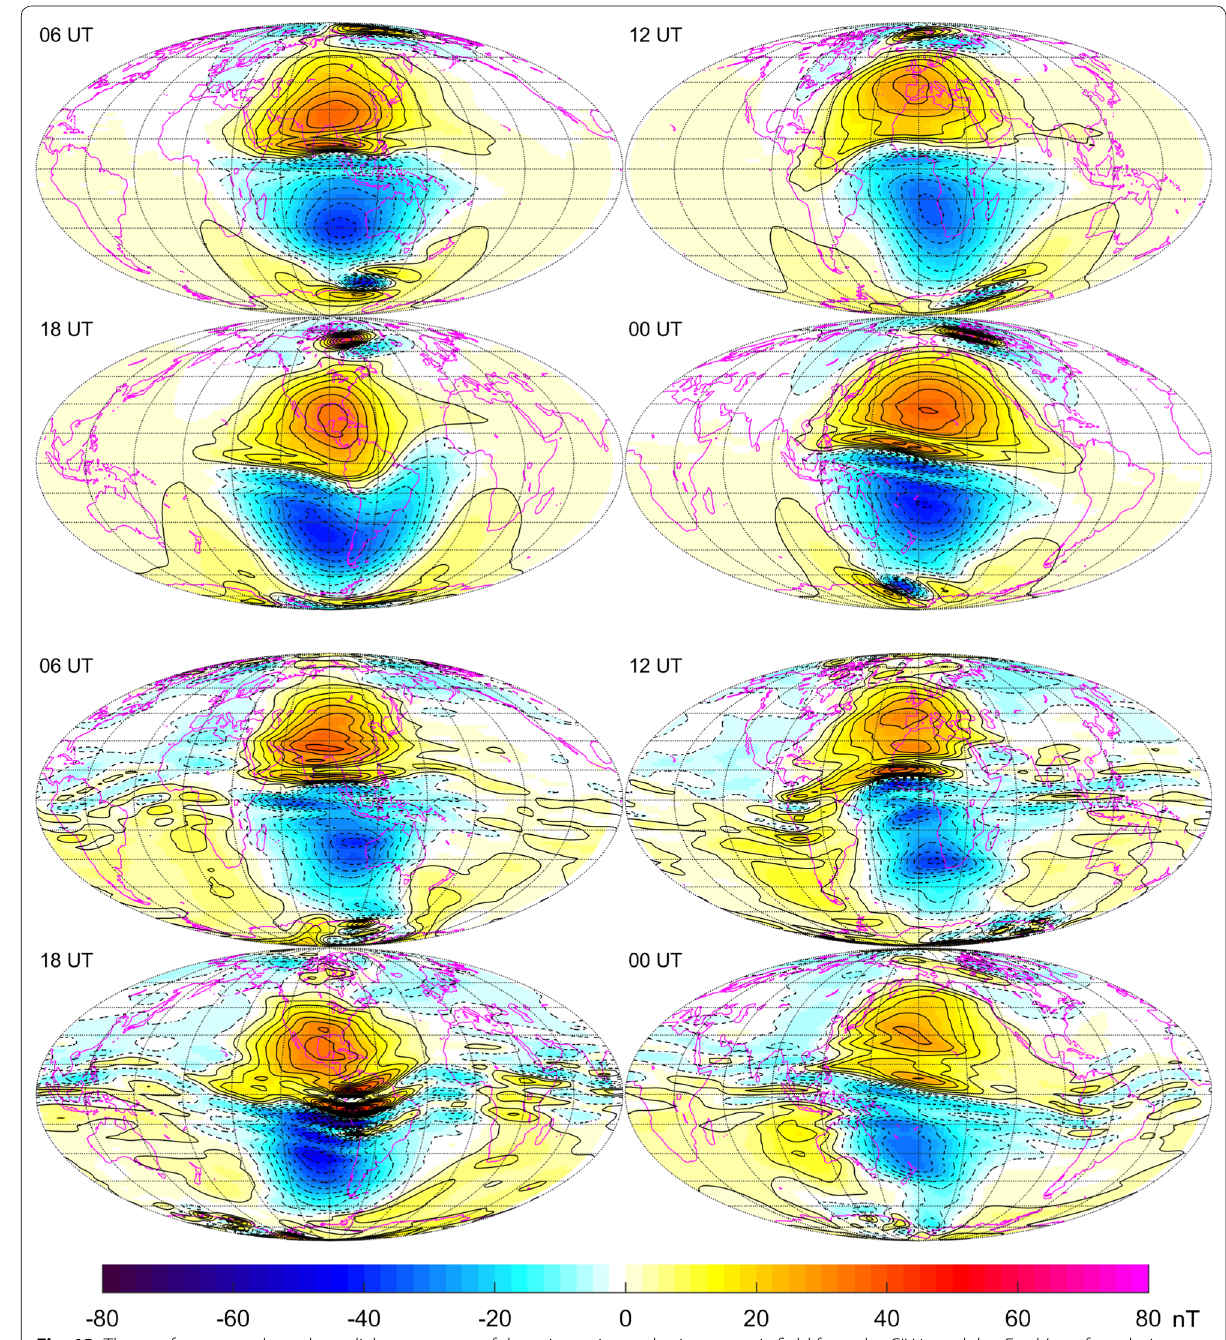
Fig. 13 The top four maps show the radial component of the primary ionospheric magnetic field from the CIY4 model at Earth’s surface during vernal equinox centered on noon local time for 06, 12, 18, and 00UT . The bottom four maps are similar to the top, but from the Swarm L2 Dedicated Ionospheric Field Inversion (DIFI) product (see Chulliat et al. 2016). Solid/dashed contour lines indicate positive/negative contours in increments of 5nT . A value of F 10.7 = 100.0 × 10 − 22 W / m 2 / Hz was used for